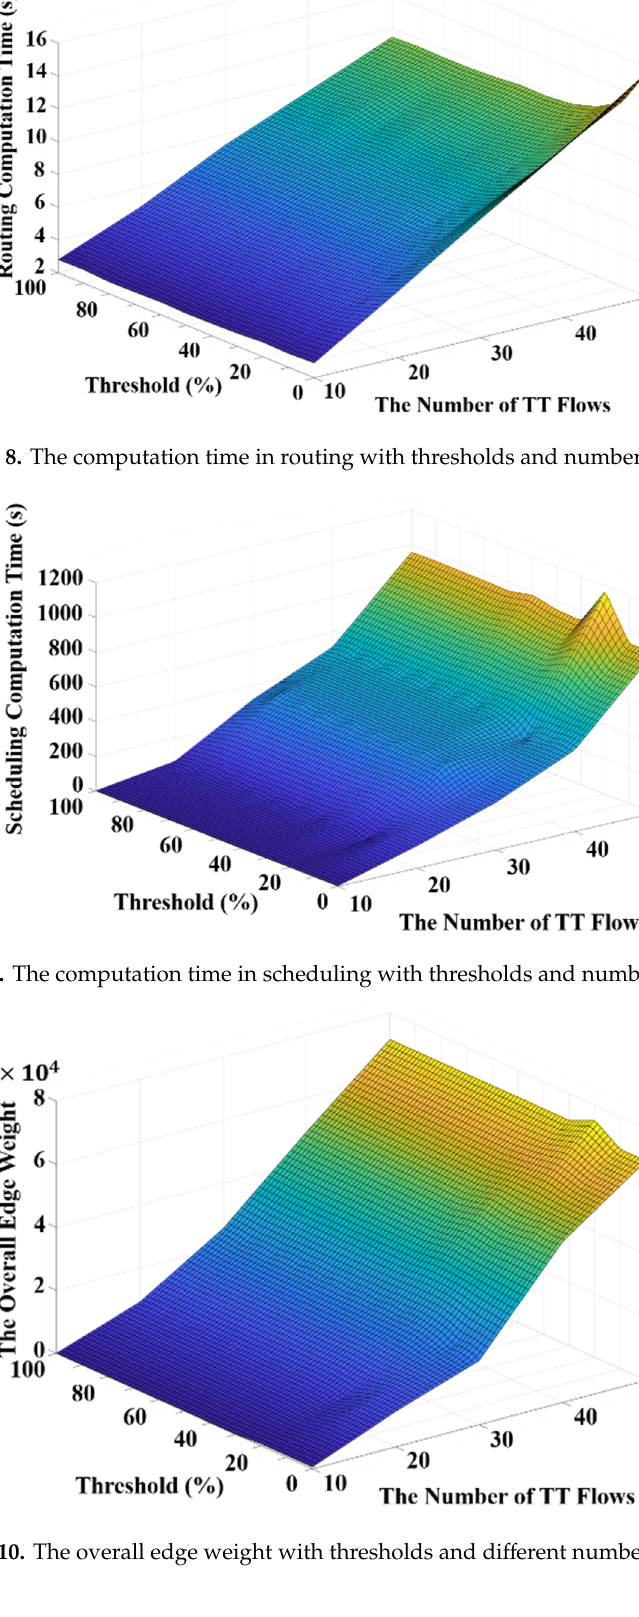
Figure 10. The overall edge weight with thresholds and different numbers of flows.